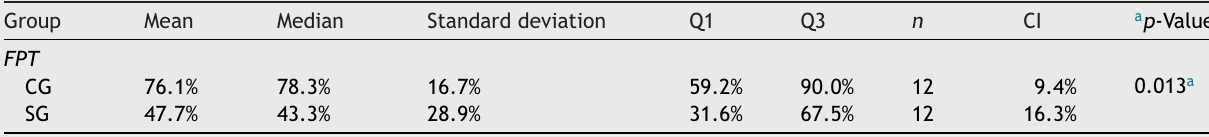
Table 2 Descriptive statistics of Frequency Pattern Test (FPT) test performance according to the group.